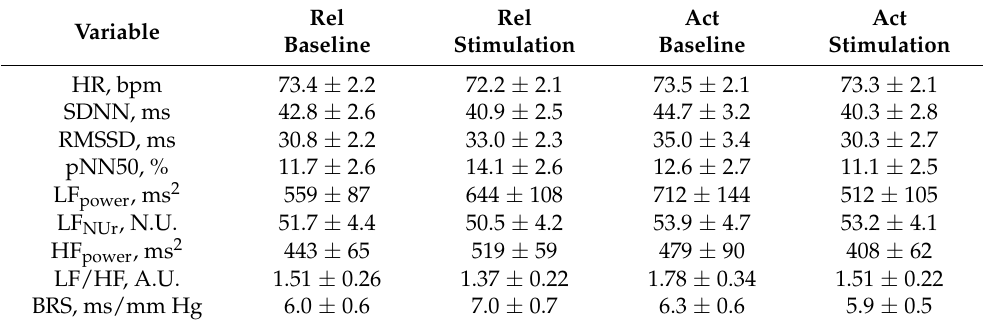
Table 1. Summary statistics of heart rate and cardiovascular variability indices in the two baseline conditions and during the subsequent relaxing (Rel) and activating (Act) musical stimulation.